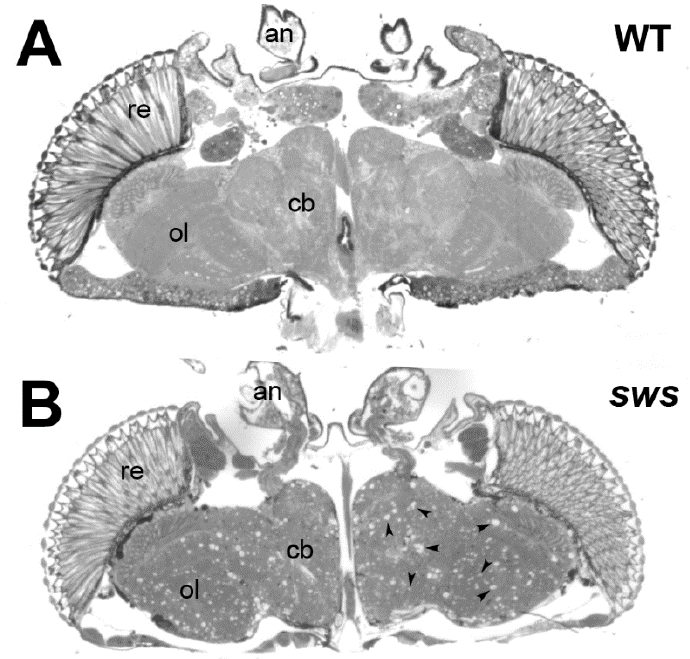
Figure 4. Loss of SWS results in neurodegeneration. ( A ) A horizontal head section from a 20d old wildtype Drosophila showing an intact brain. ( B ) In a head section from a 20d old sws 1 mutant the neurodegeneration is visible by the formation of numerous sponfgiform lesions (some are indicated by the arrowheads) in all brain areas. re = retina, ol = optic lobes, cb = central brain, an = antennae.